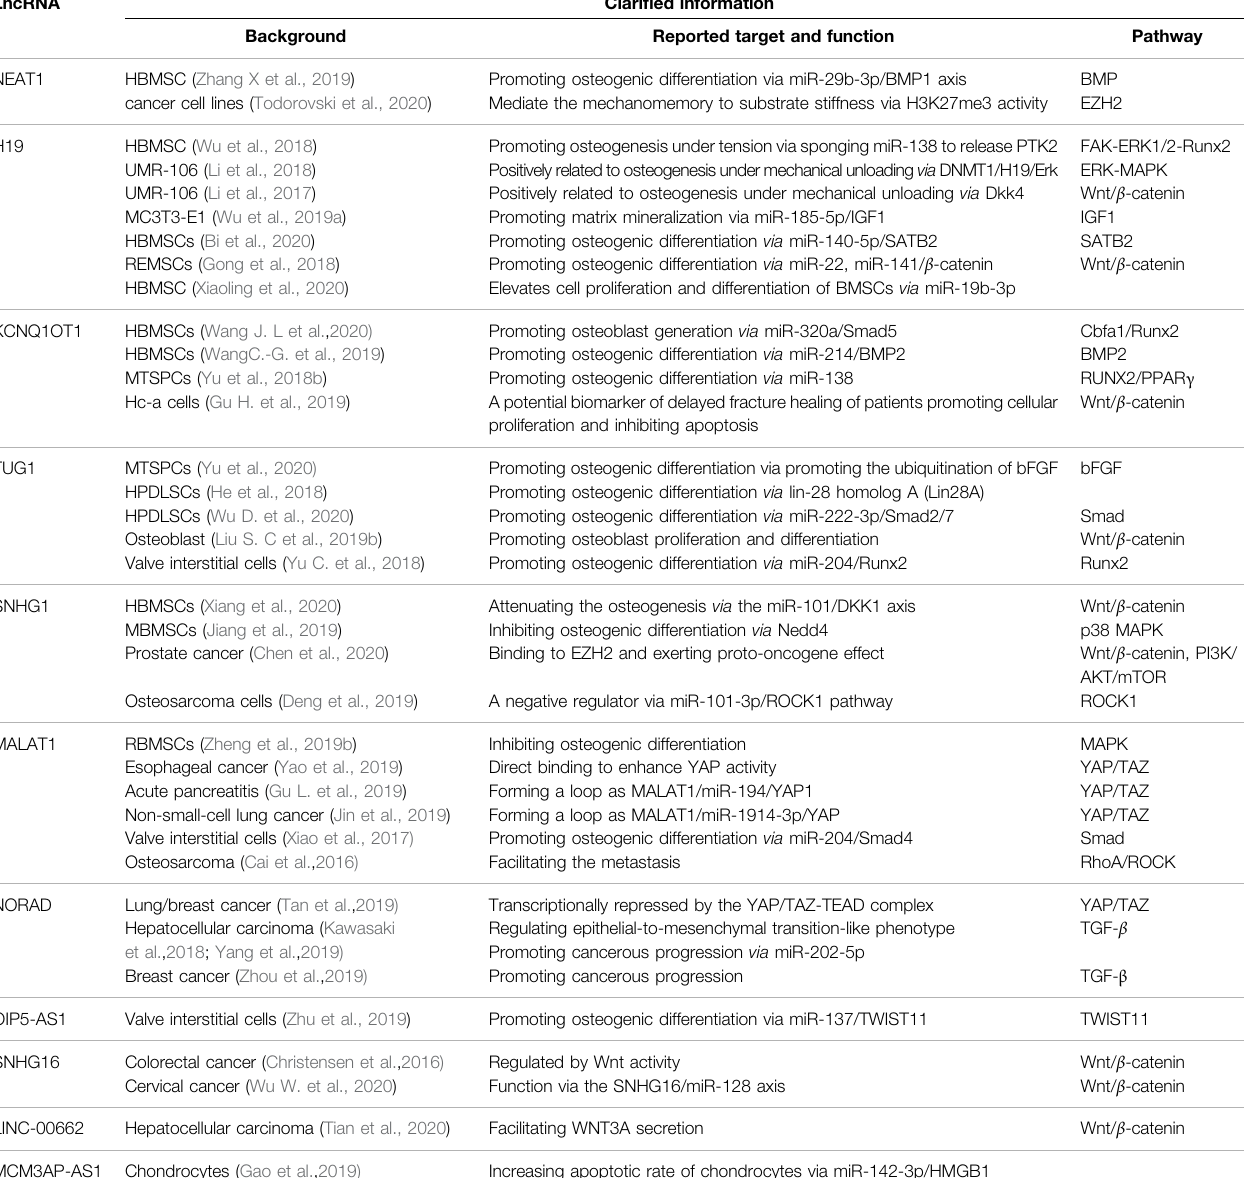
TABLE 3 | Pathway mapping of force-related